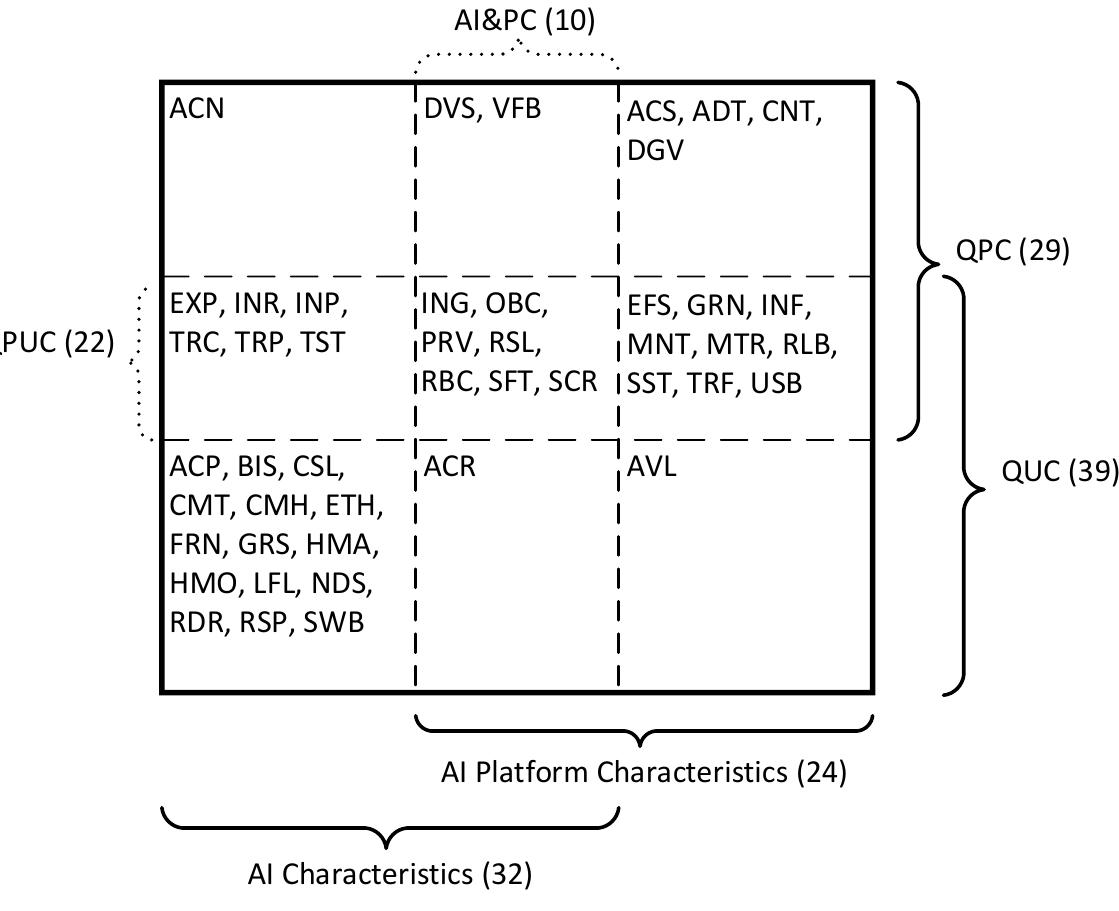
Figure 3. Classification map of AI quality characteristics according to Table 3.